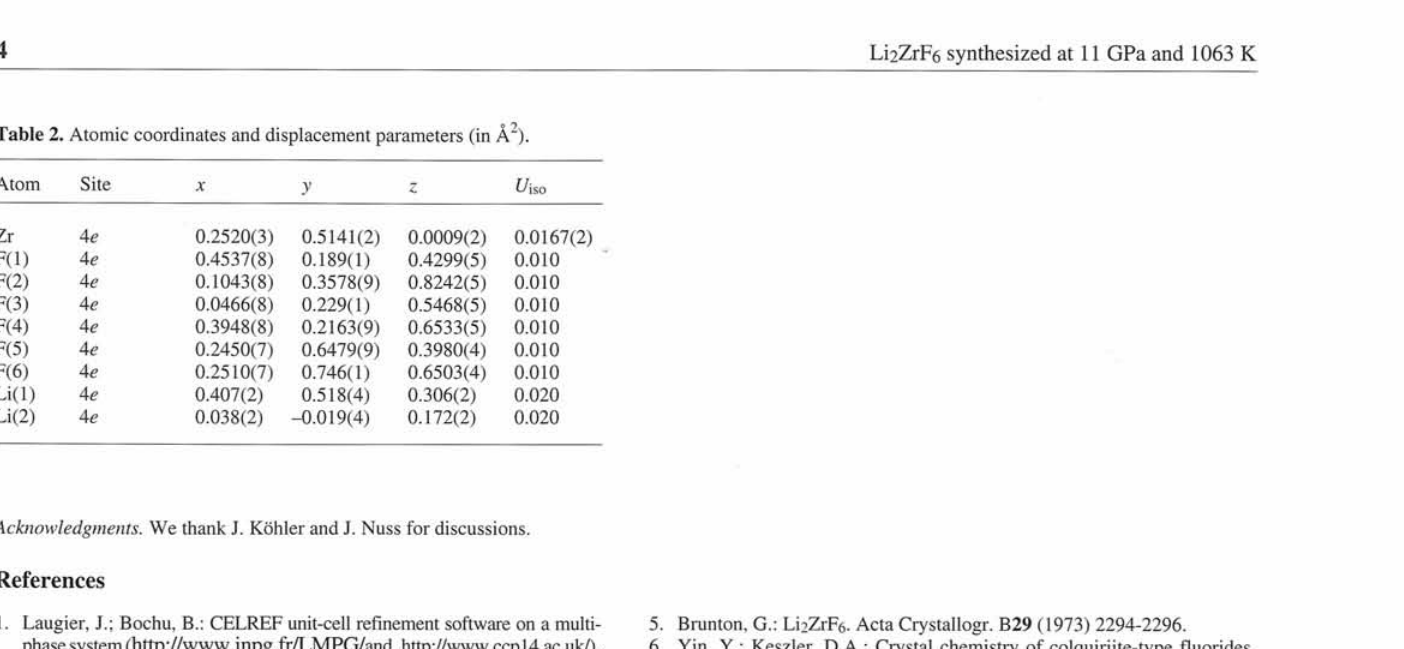
Table 2. Atomic coordinates and displacement parameters (in Â 2